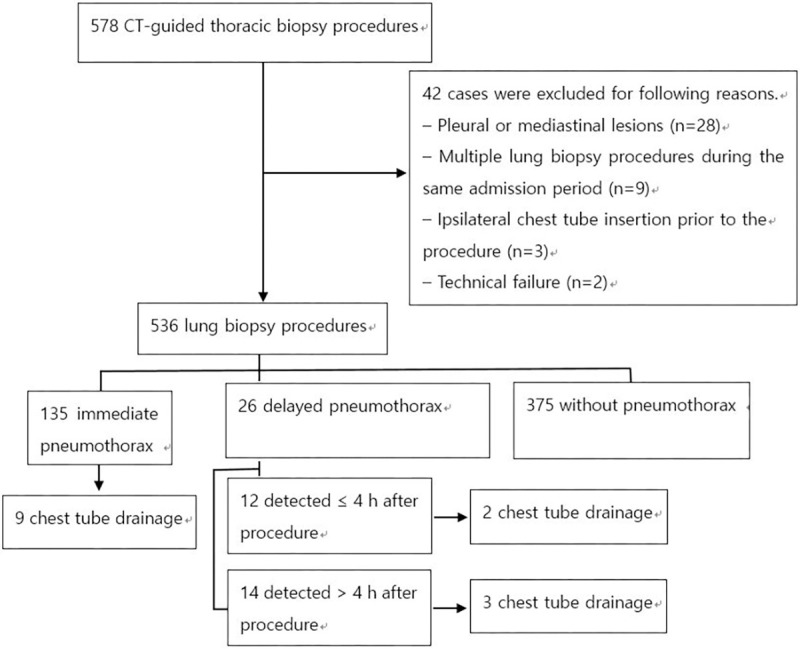
Flow diagram of the study.